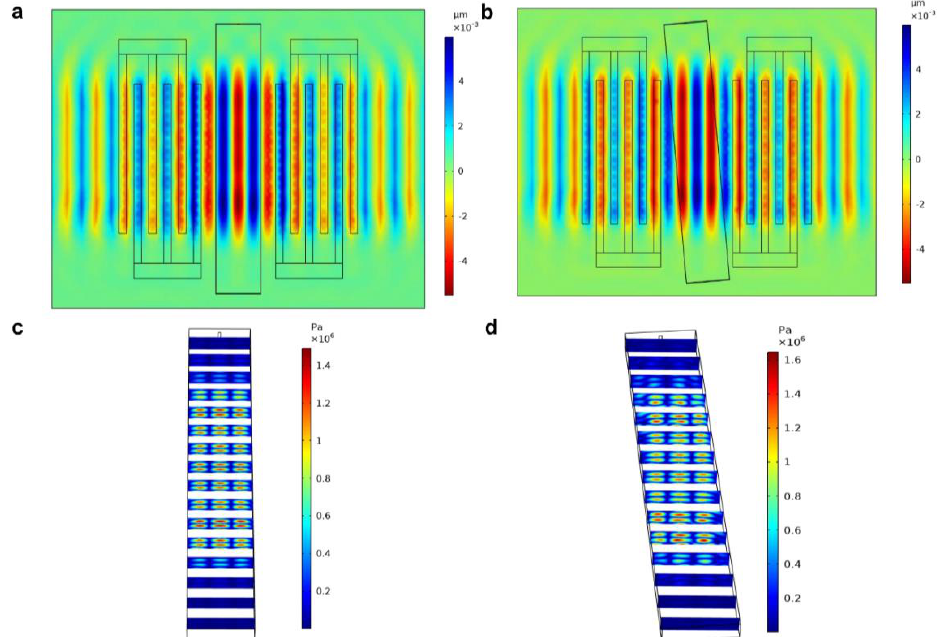
Figure 4. The displacement generated on the substrate surface when the channel was placed in parallel ( a ) and placed with an angle ( b ) to the IDT. The acoustic pressure distribution in the channel when the channel was placed in parallel ( c ) and placed with an angle ( d ) to the IDT.